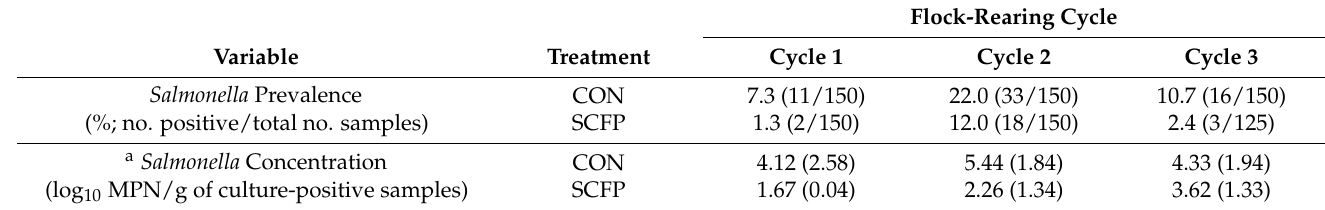
Table 2. Observed prevalence and load of Salmonella enterica in the ceca of broilers at market age fed either CON or SCFP diets by flock-rearing cycle and estimated treatment level within-cycle total burden.